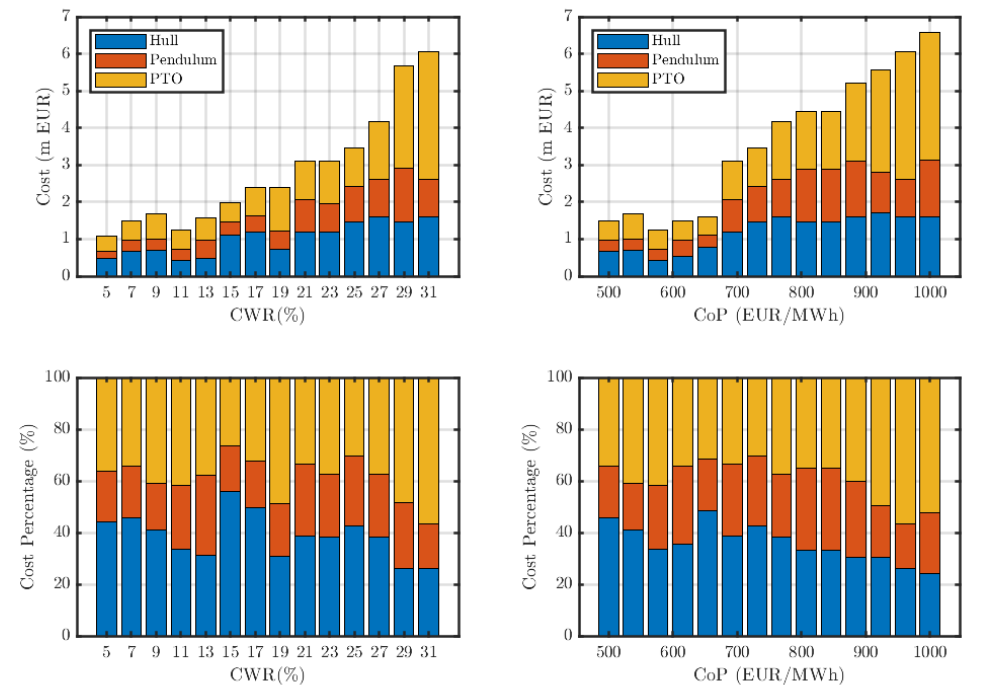
Figure 22. Hull, pendulum and PTO absolute and percentage cost. On the left: 14 individuals with the highest CWRs for each CWR-bin. On the right: 14 individuals with the lowest CoPs for each